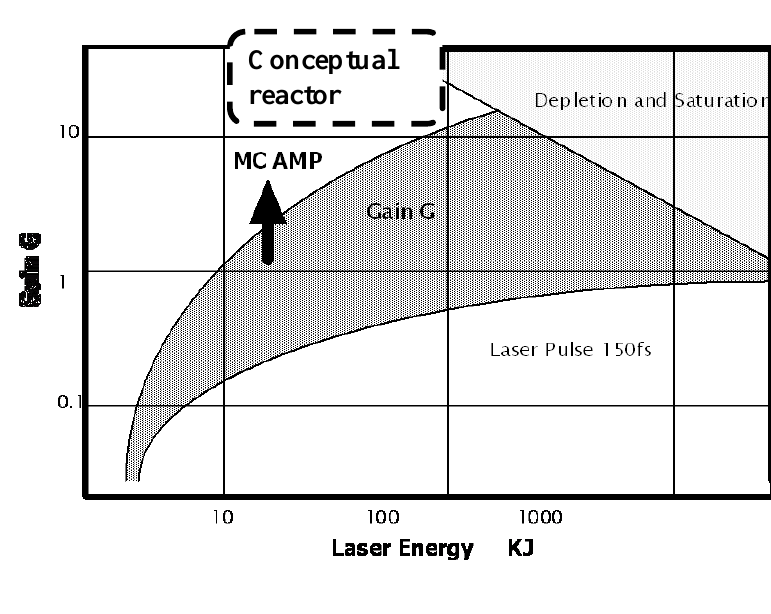
Figure 16. Gain of the